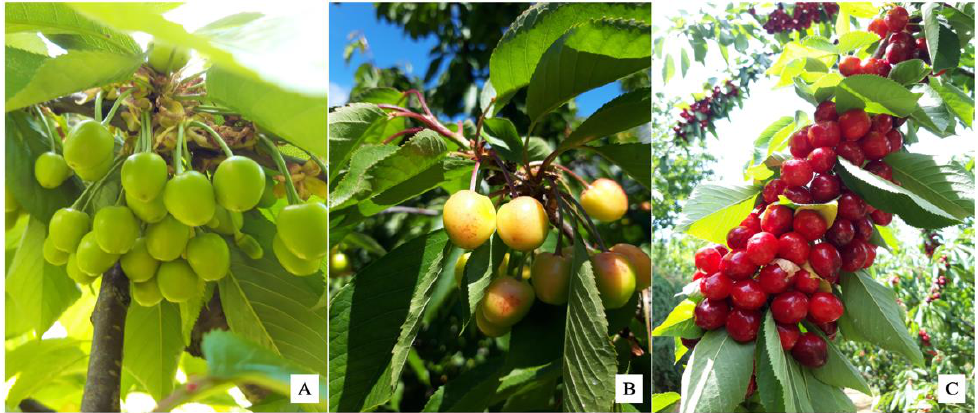
Figure 7. Phenological stages in which treatments were carried out on the sweet cherry trees cv. Lapins . 77 BBCH ( A ); 81 BBCH ( B ); and 86 BBCH ( C